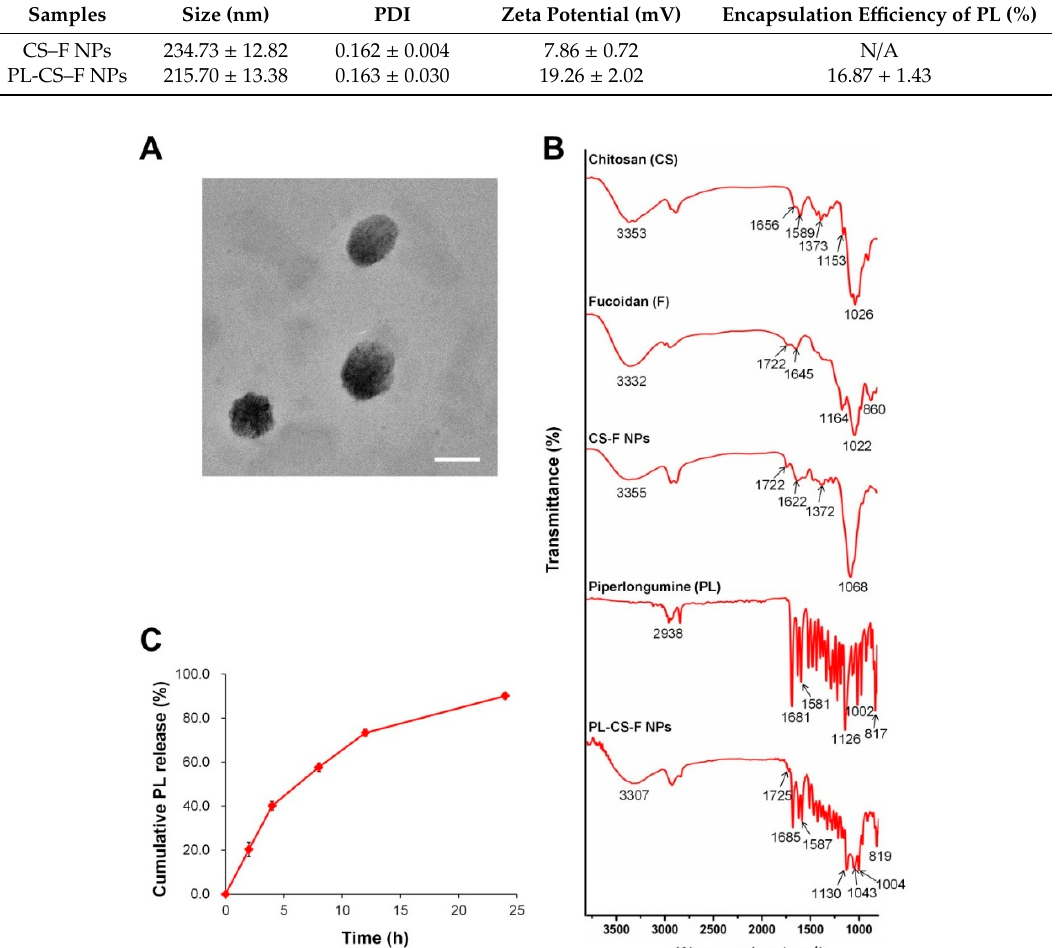
Table 1. Size, zeta potentials, polydispersity index (PDI), and piperlongumine (PL) encapsulation